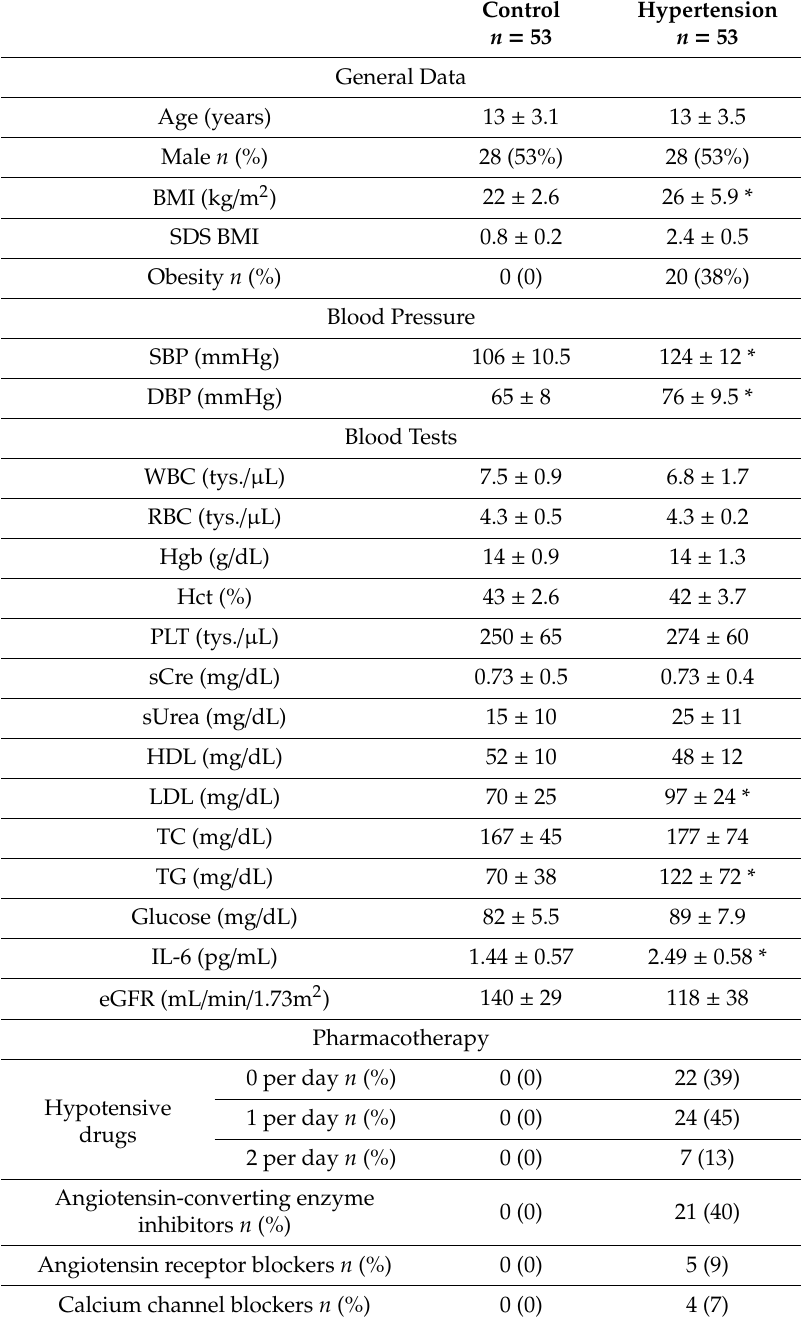
Table 1. Clinical characteristics of children with hypertension and healthy